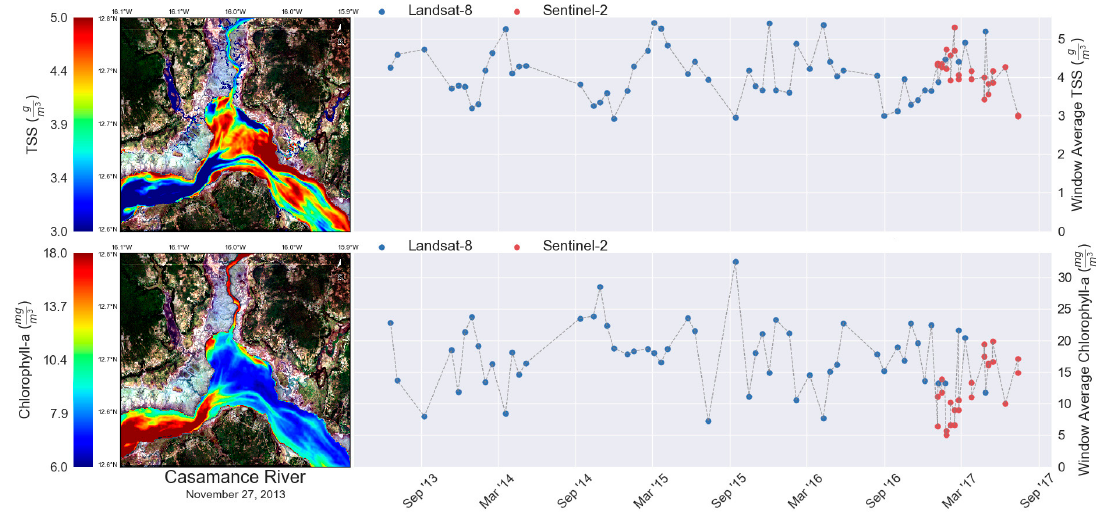
Figure 12. Time-series of average TSS (g/m 3 ) and Chl (mg/m 3 ) for a segment of the Casamance River in Senegal for 2013–2017 period . The data points correspond to the area-average products (i.e., averaging all values within the sample products shown on the left panel). Spatial variability is apparent in the maps on the left.